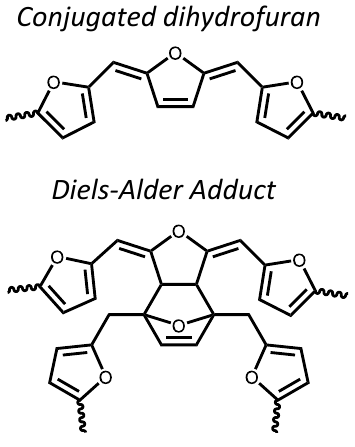
Figure 4. Magnified HSQC spectra of PFA+ (blue) and PFA° (red) of the dienes and ethers areas. The red spectrum is stacked on top of the blue one.